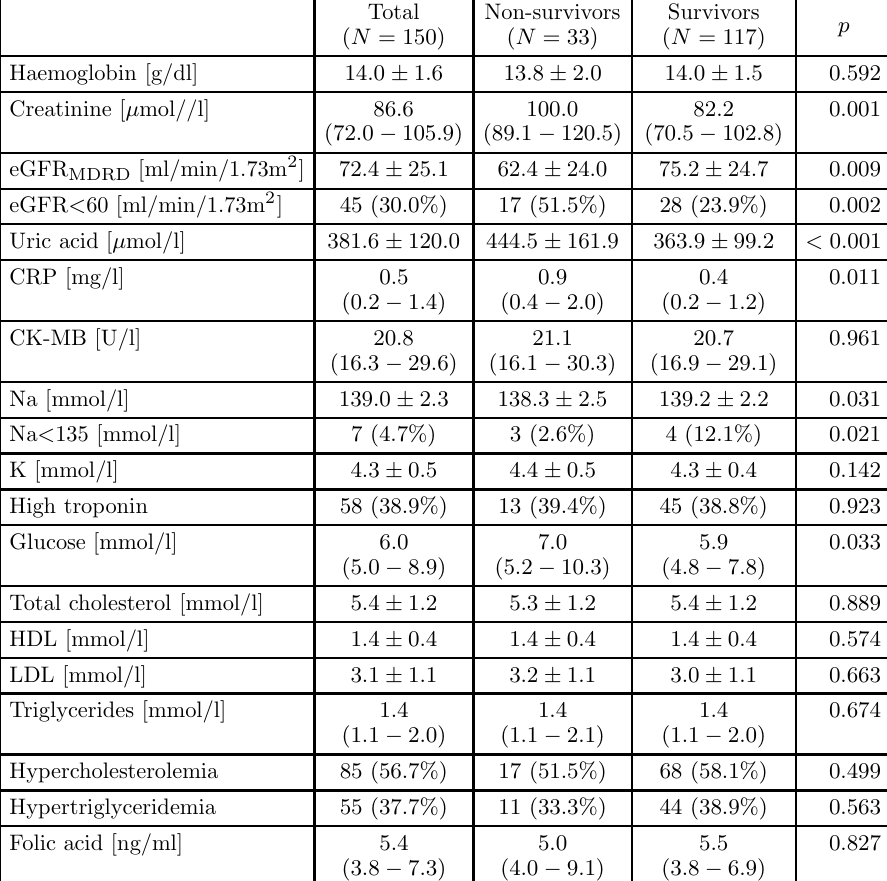
Table 2. Baseline blood test results and lipid profiles in survivors and